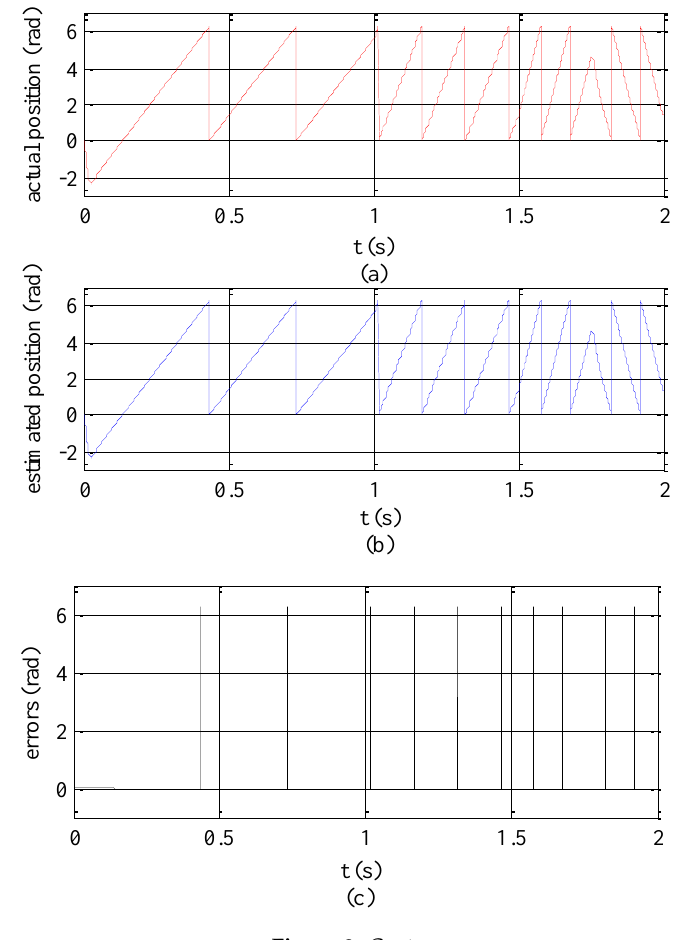
Figure 8. Waveforms of rotor speed: ( a ) actual rotor speed with speed changes; ( b ) estimated rotor speed with speed changes; ( c ) errors between actual rotor speed and estimated rotor speed with speed changes; ( d ) actual rotor speed with torque changes; ( e ) estimated rotor speed with torque changes; ( f ) errors between actual rotor speed and estimated rotor speed with torque changes.